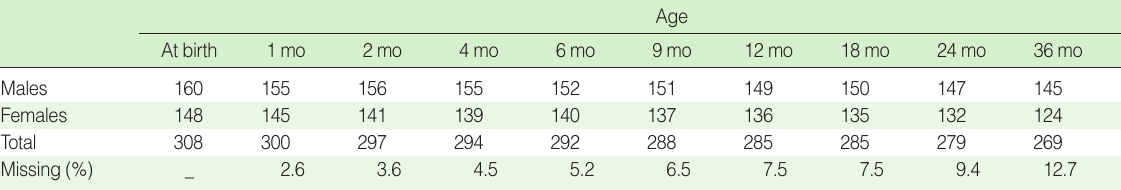
Table 1. Number of subjects measured at various target ages